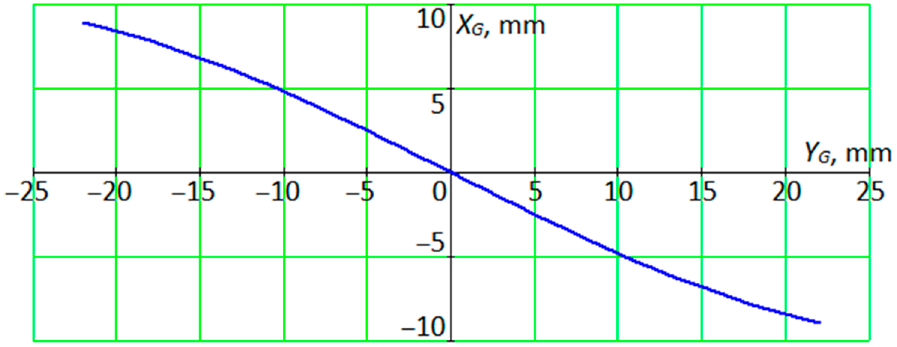
Figure 17. Clutch platter surface profile for equal clutch factors in coordinates X G , Y G [mm].